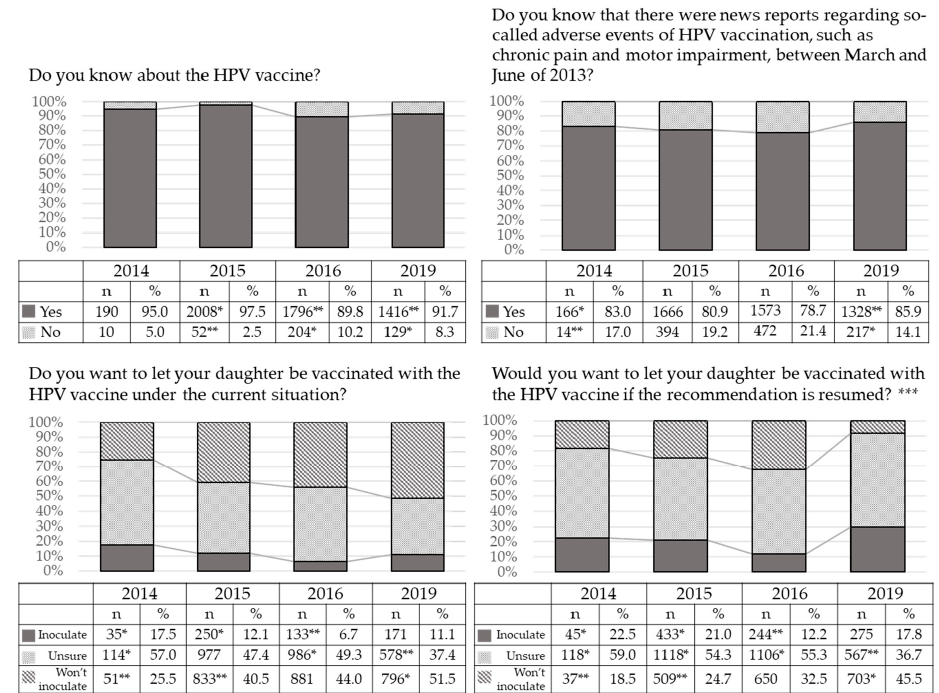
Figure 2. Changes in response to each survey question over time. The results of the present survey were compared to those of internet surveys we had conducted at 9 months, 23 months, and 32 months